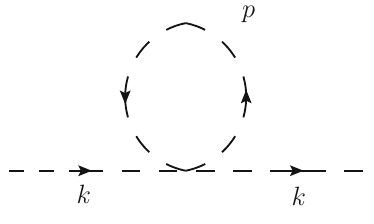
Fig. 3 One-loop graph in the scalar model with self interaction λφ